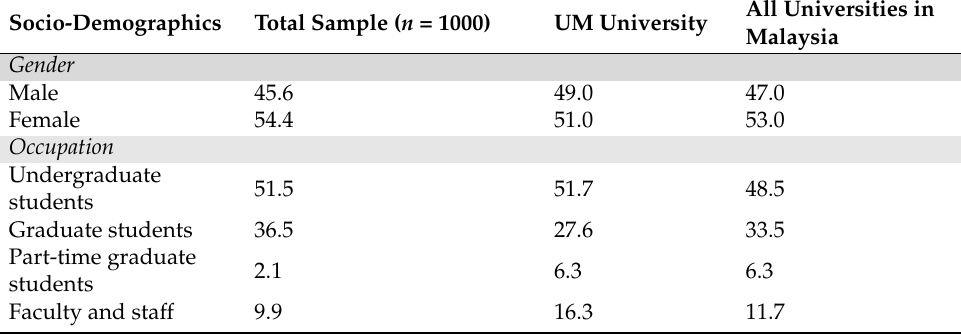
Table 2. Comparison between the survey sample and the university population in